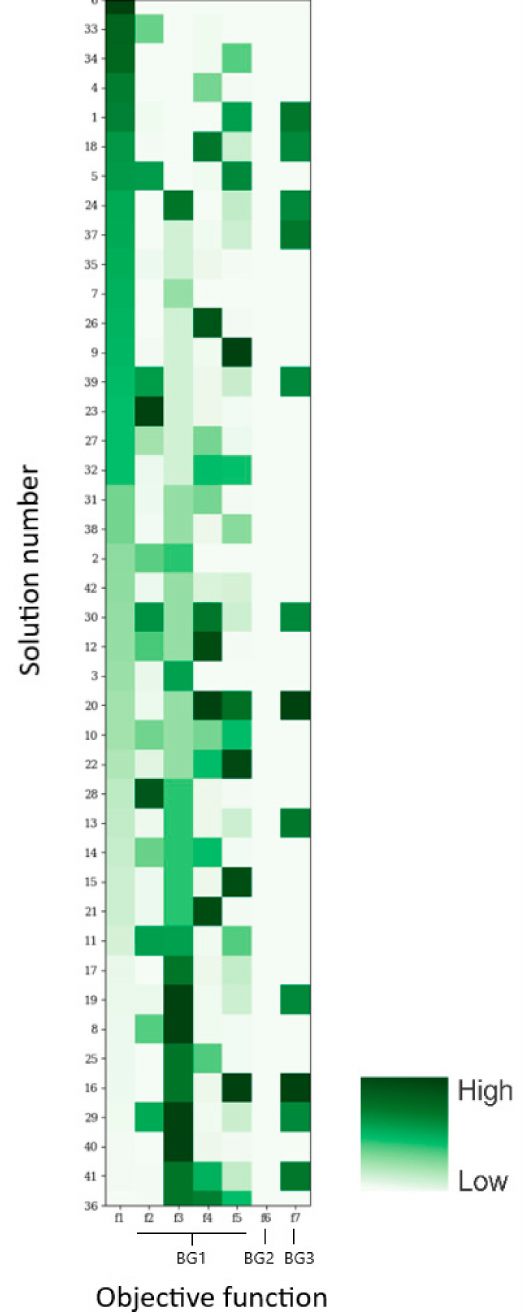
Figure 8. Heatmap showing the sorted normalized objective functions scores (on the y -axis) for the e-flow requirements (BG1 = Biological Group 1; BG2 = Biological Group 2; BG3 = Biological Group 3) in relation to the municipal water supply objective (f1) (on the x -axis). Tile hue indicates the score (dark green = high/best scores; light green = low/worst scores). Presented result is for run #1 for DP1, dry